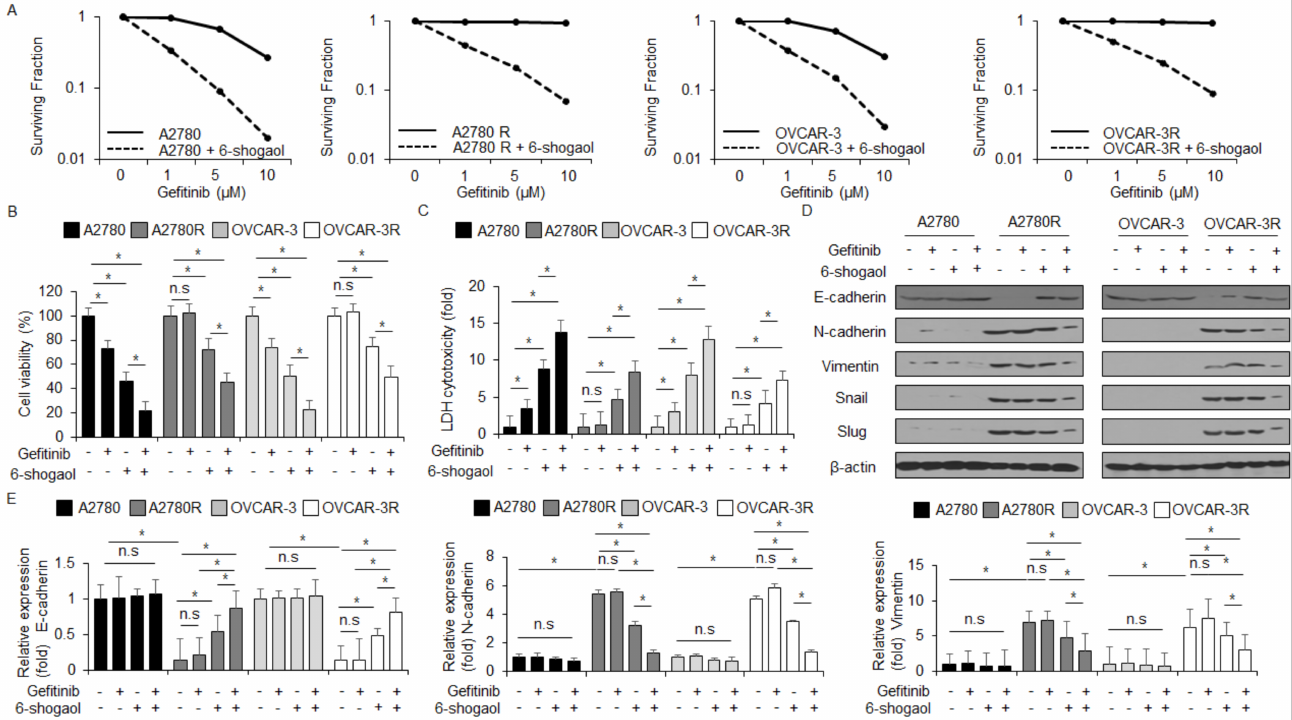
Figure 8. Gefitinib in combination with 6-shogaol overcomes resistance in gefitinib-resistant ovarian cancer cells. ( A ) A colony formation assay was performed at indicated doses (1, 5, or 10 µ M) of gefitinib and then the survival fraction was calculated using the surviving fraction formula in A2780, A2780R, OVCAR-3, and OVCAR-3R; *, p <0.05. ( B – E ) A2780, A2780R, OVCAR-3, and OVCAR-3R cells were treated with 6-shogaol (30 µ M, 24 h) and gefitinib (1 µ M, 24 h). WST-1 assay and LDH assay were carried out along with a Western blot analysis for E-cadherin, N-cadherin, vimentin, Slug, and Snail and real-time RT-PCR for E-cadherin, N-cadherin, and vimentin; *, p < 0.05. n.s = not significant. β -actin was used as the RNA and protein loading control. β -actin was used as the protein loading